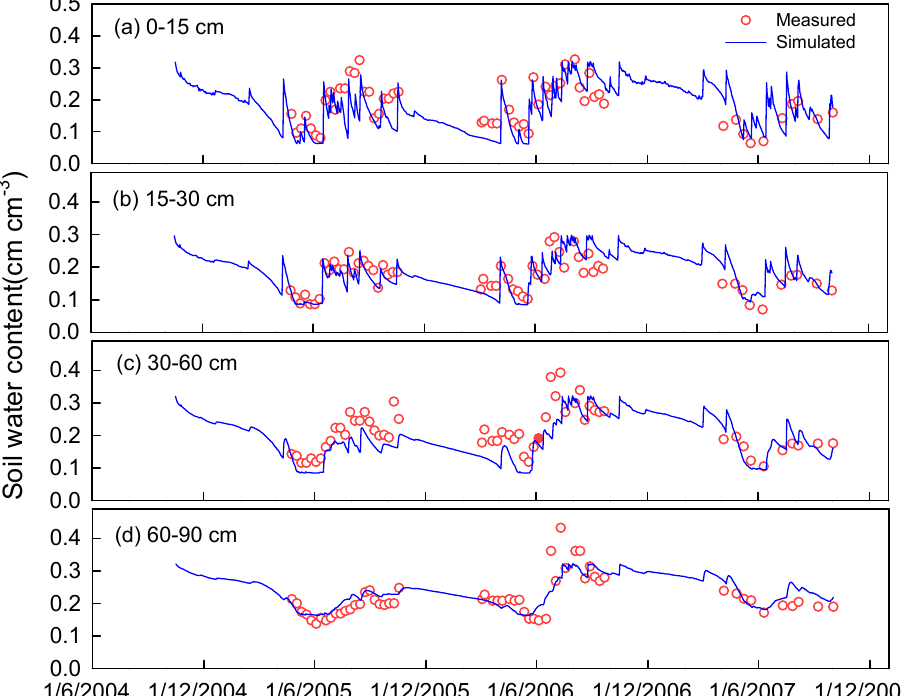
Figure 2. Comparison of simulated and measured soil water content at different depths for 2H1Y_RI.